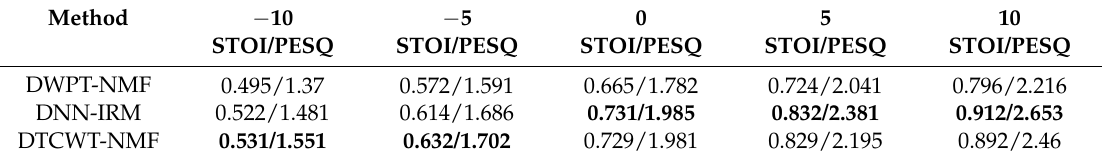
Table 6. Performance comparison among three methods across five SNR